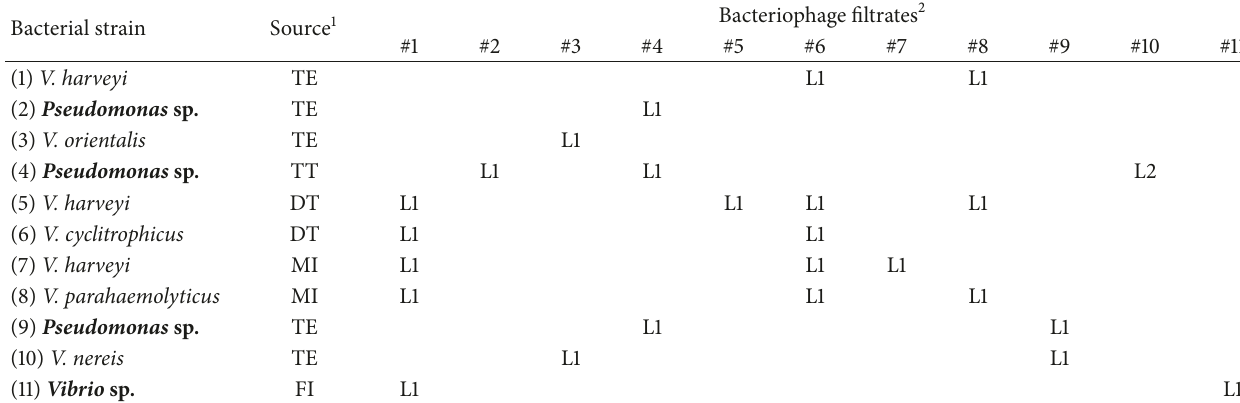
Table 3: Bacterial susceptibility to 11 bacteriophage